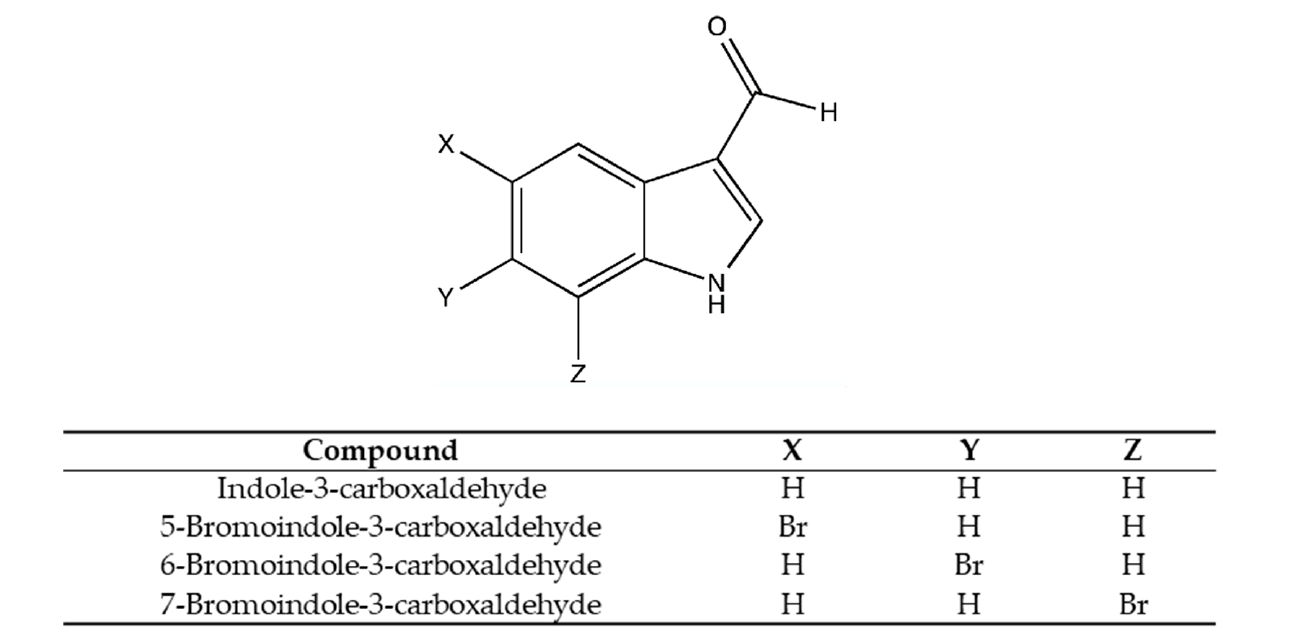
Figure 1. Test compounds and structures.